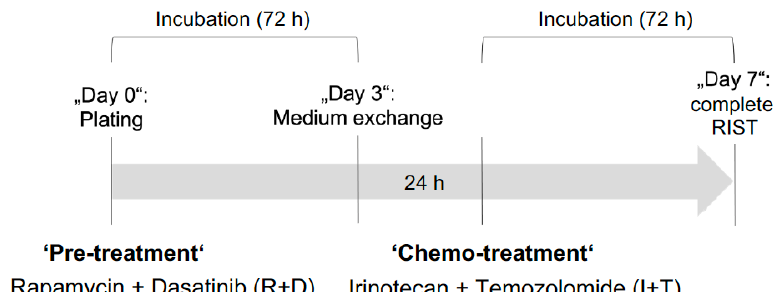
Figure 4. Scheme of the experimental design for the in vitro RIST treatment protocol.